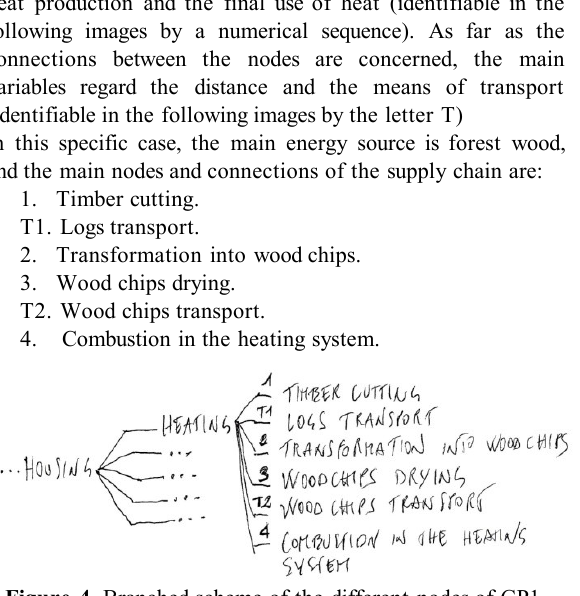
Figure 4. Branched scheme of the different nodes of GP1